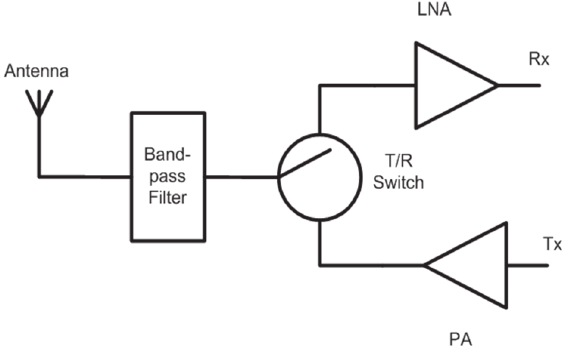
Figure 1 - T/R switch in RF transceiver